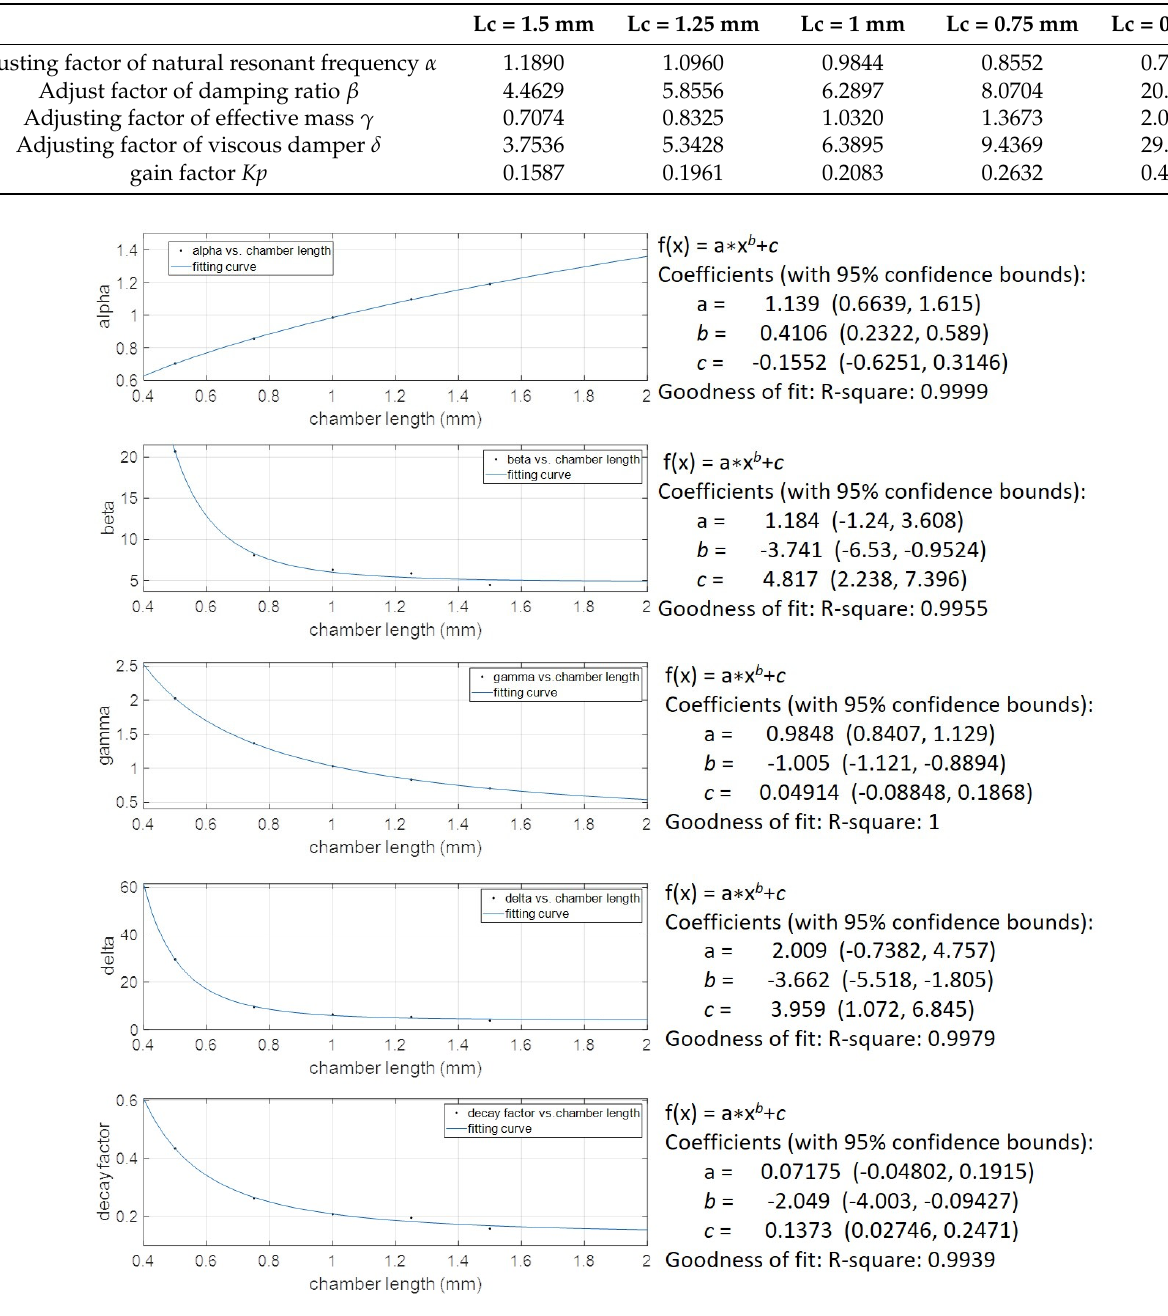
Figure 16. The defined adjusting factors of natural resonant frequency, damping ratio, effective mass, viscous damper, and ( P 3/ P 2) gain factor are well-fitted two-term power series curves.